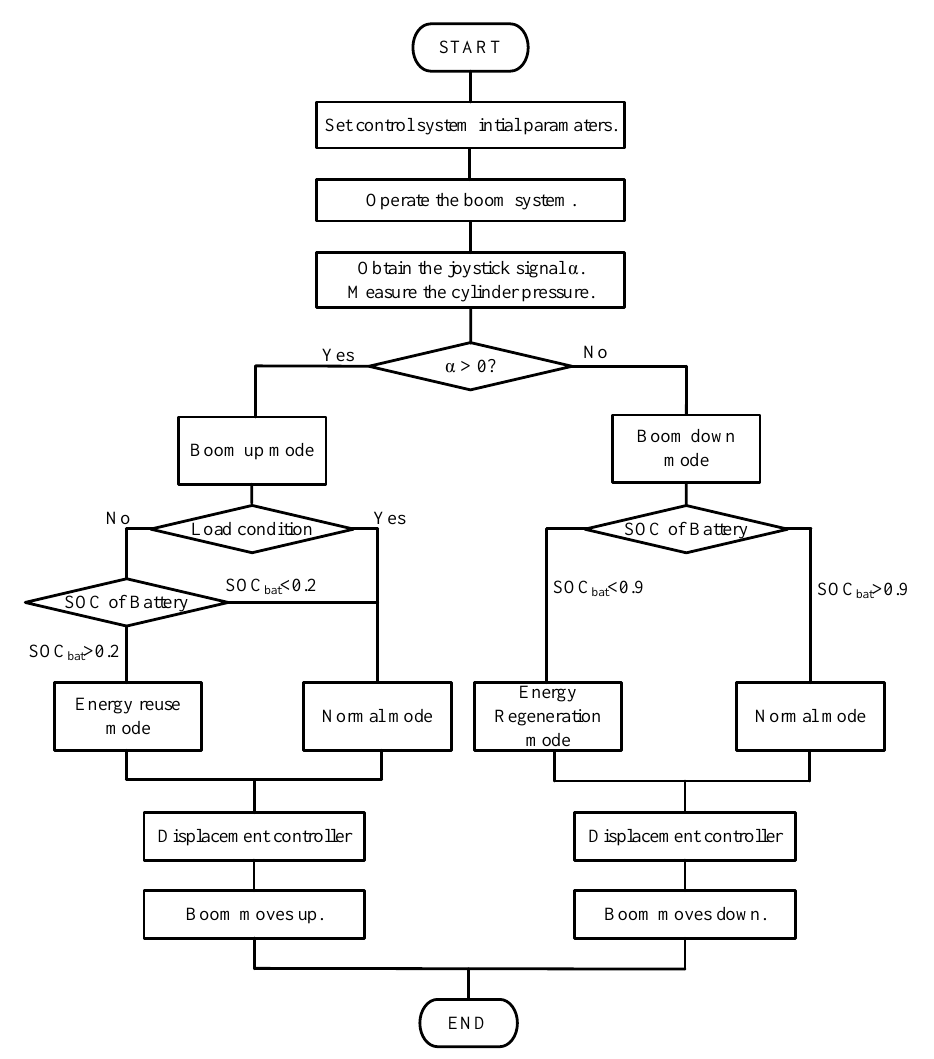
Figure 6. Control strategy of the proposed system.